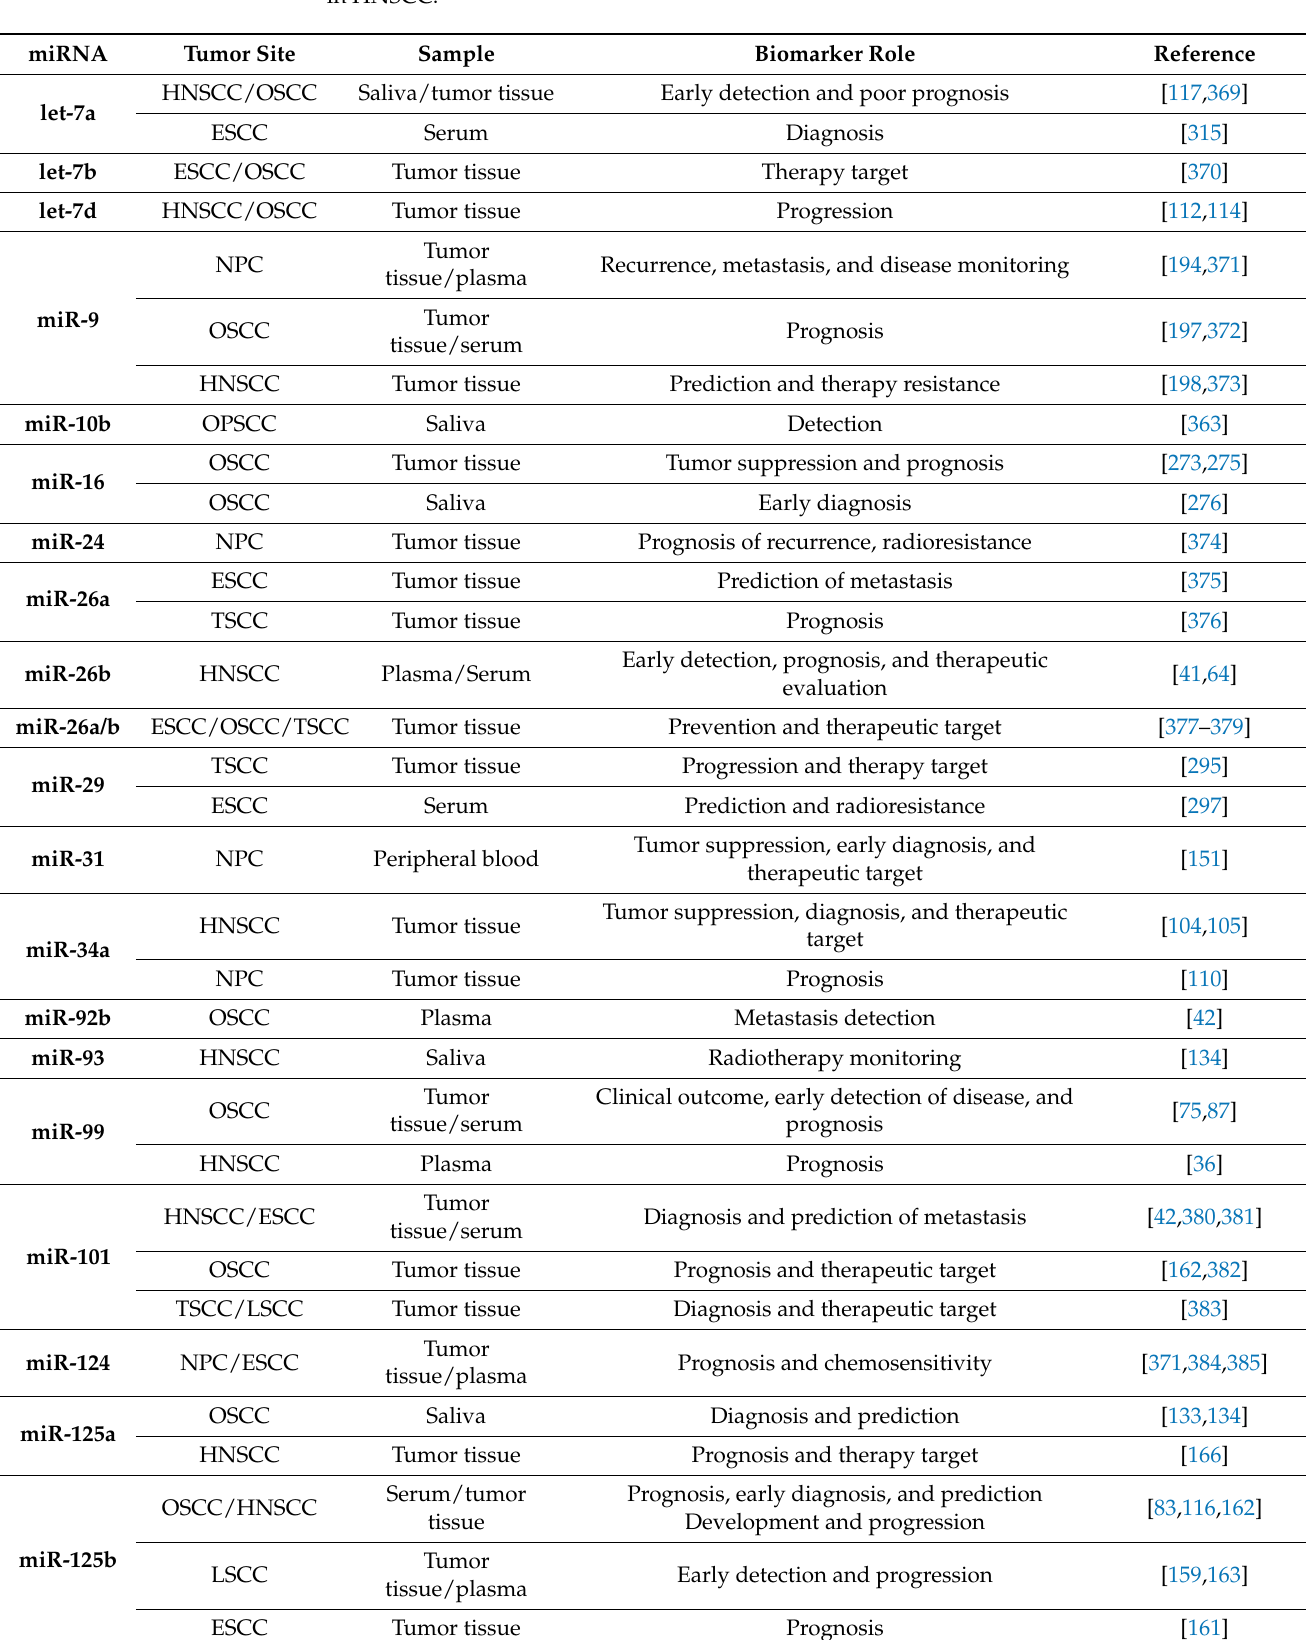
Table 2. Summary of the most common downregulated miRNAs reported as potential biomarkers in